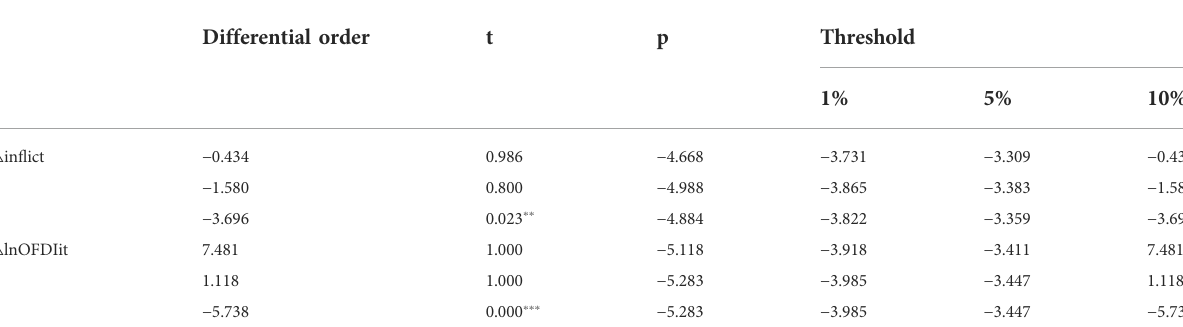
TABLE 3 ADF test results.